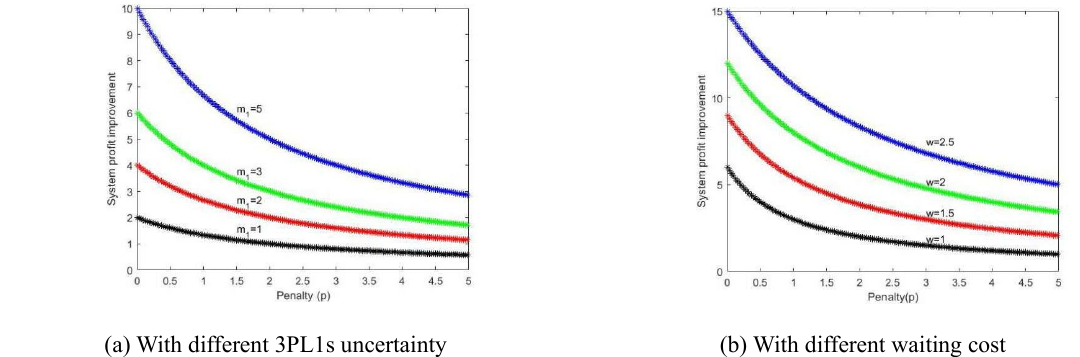
Fig. 9. Profit improvement in penalty